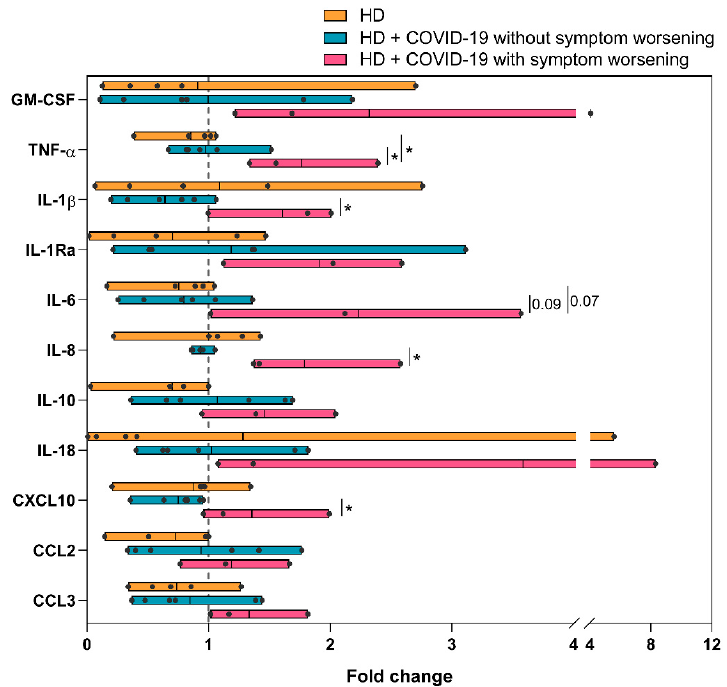
Figure 5. Change in the in vitro cytokine production by monocytes after hemodialysis. Comparison of fold change in cytokines levels pre- and post-hemodialysis between uninfected HD patients, HD + COVID-19 patients without worsening of COVID-19 symptoms and HD + COVID-19 patients with worsening of COVID-19 symptoms after receiving hemodialysis. Dotted line represents unchanged cytokine level, *, p < 0.05.